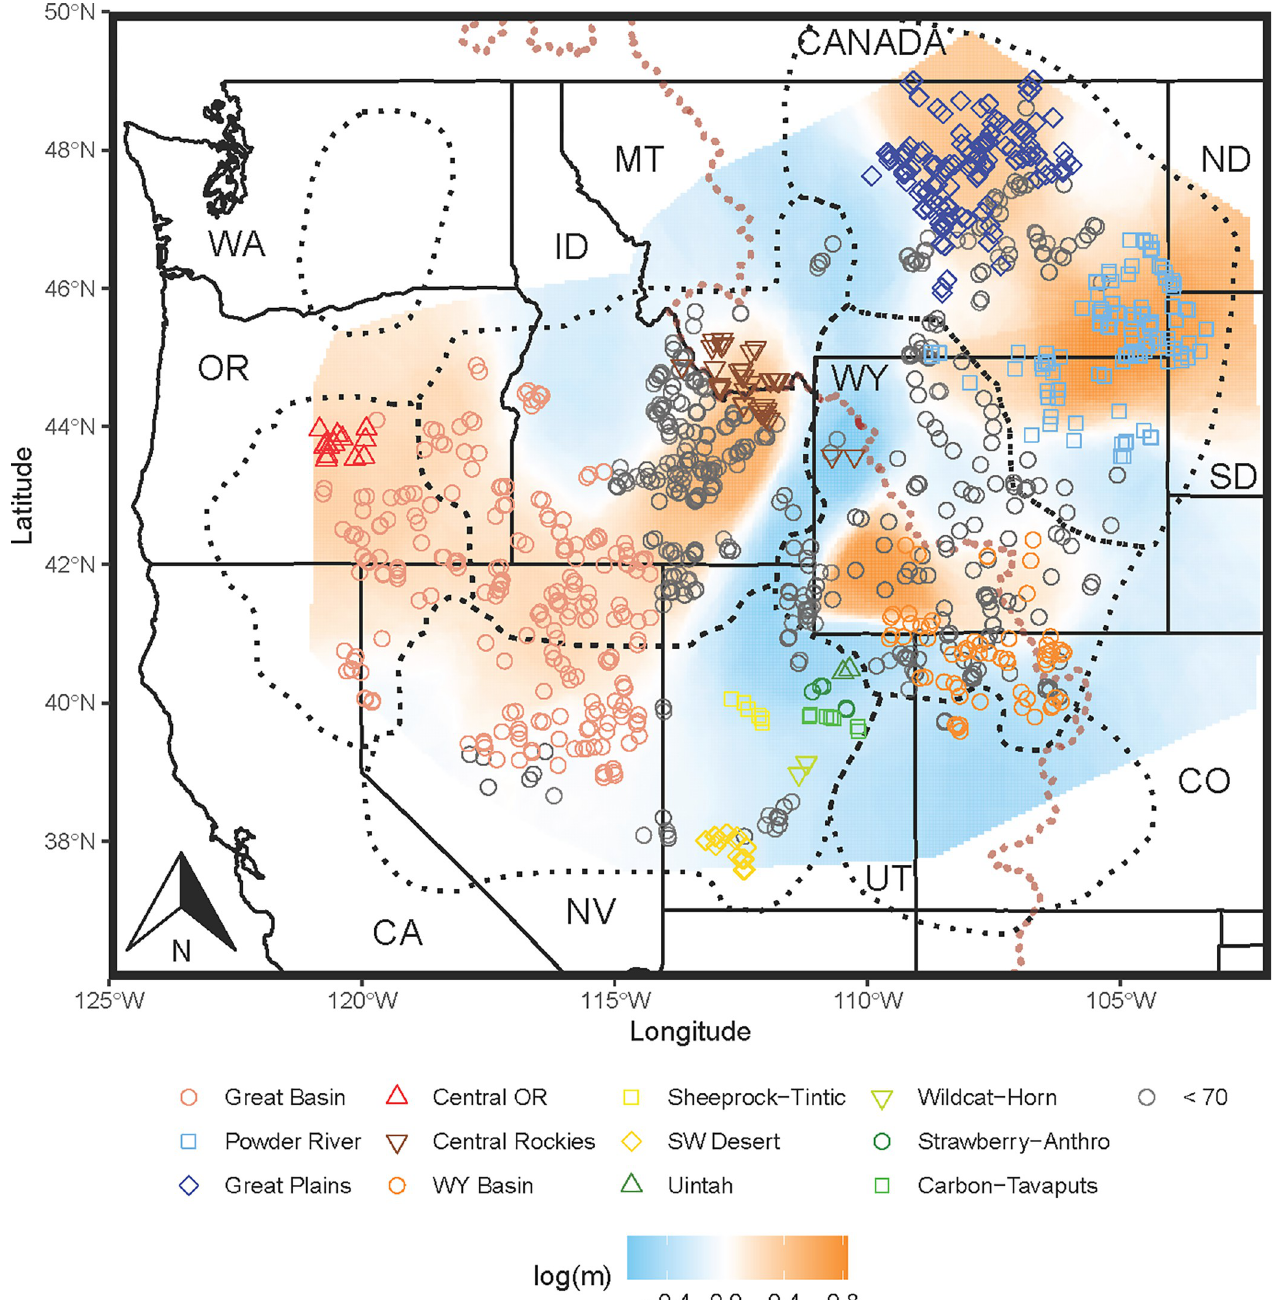
Fig 5. The 12 Greater Sage-grouse subpopulation centers identified using the spatial iterative bifurcation process overlaid on the effective migration surface. The color and symbol represent each of the 12 subpopulation centers. Open grey symbols represent individuals outside of subpopulation centers. Effective migration rates are shown on a log scale where the zero value (white) indicates the mean effective migration rate, positive values (orange) indicate greater than average effective migration and negative values (blue) indicate those less than average. The dotted red line represents the Continental Divide. Tan polygons represent Priority Areas for Conservation and dotted black lines represent the seven sage-grouse management zones (MZ). State names are represented by the following abbreviations California (CA), Colorado (CO), Idaho (ID), Montana (MT), Nevada (NV), North Dakota (ND), Oregon (OR), South Dakota (SD), Utah (UT), Washington (WA), and Wyoming (WY).